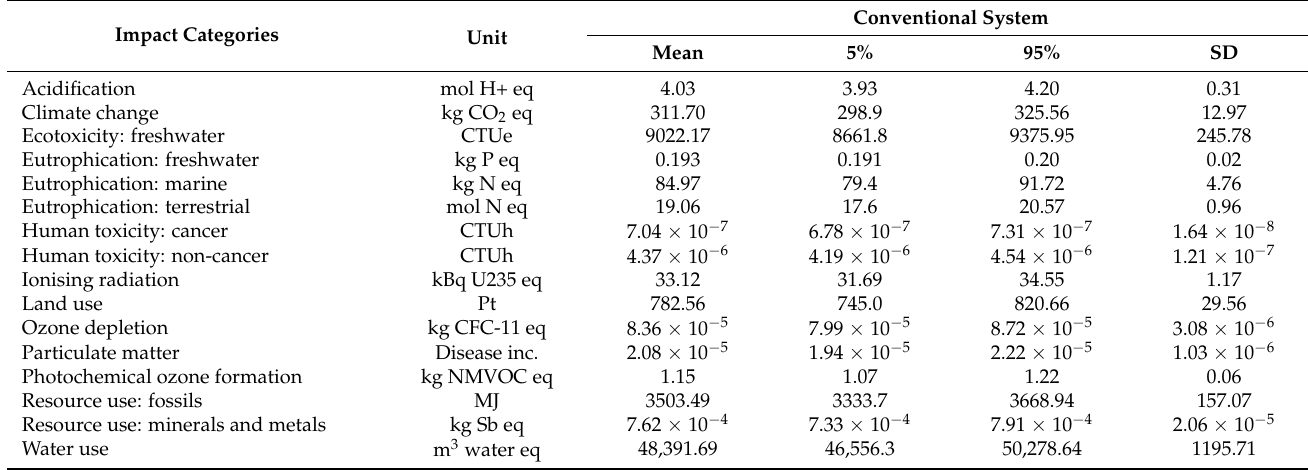
Table A3. Results of Monte Carlo simulation for 1 ton of table grapes at the farm gate with conventional (groundwater) irrigation.